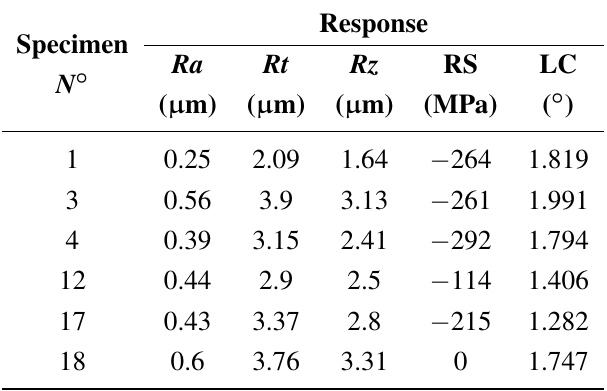
Table 4. Measurement of parameters of surface